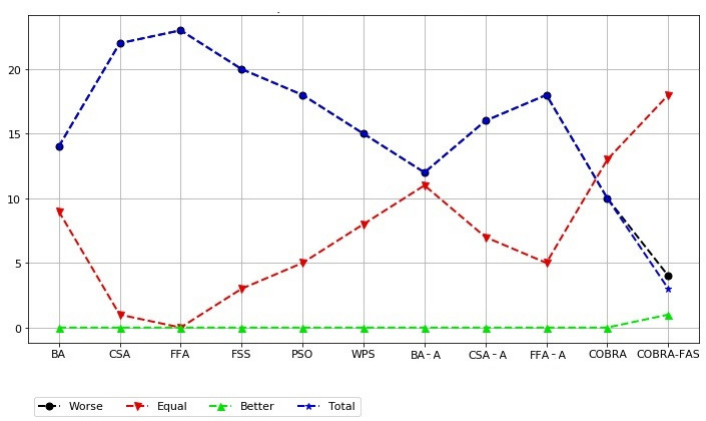
Figure 2. Results of the Mann-Whitney statistical test with p = 0.01, comparison of COBRA-SHA with other approaches